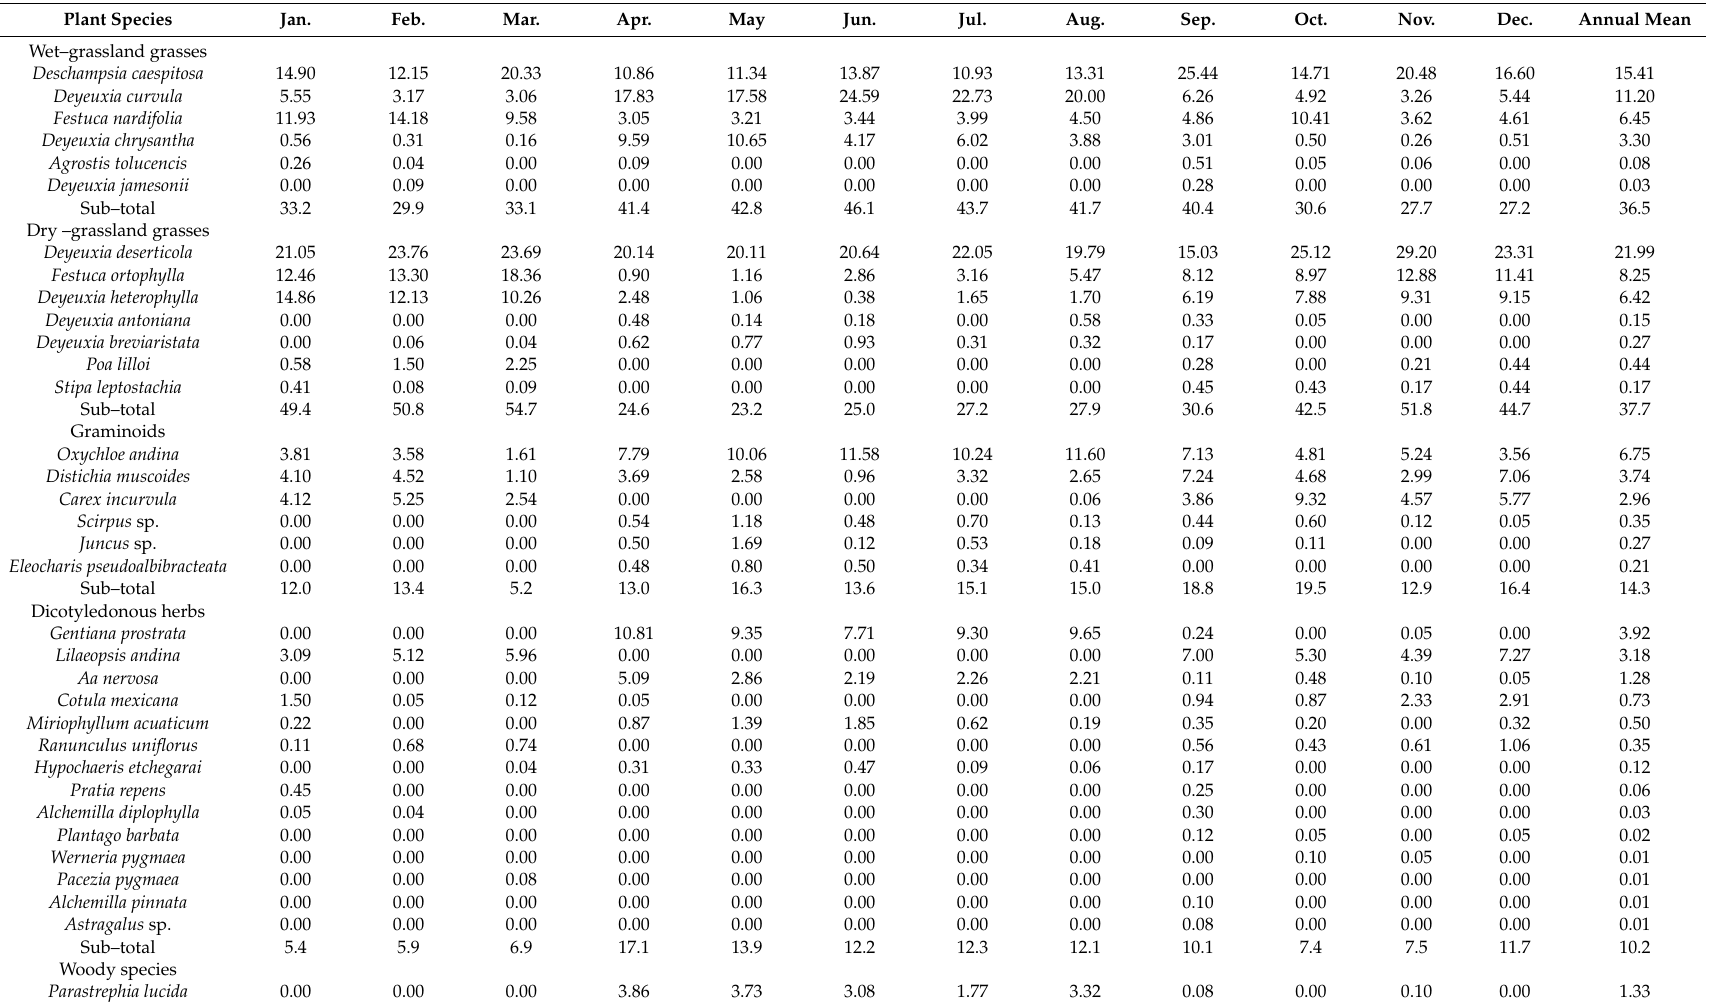
Table 2. Mean monthly contribution of di ff erent plant species to the diet of vicuñas that graze on natural grasslands of a sector of the Chilean highlands in Caquena, Putre County (18 ◦ 03 S, 69 ◦ 13’ W; 4425 m.o.s. l.), Arica and Parinacota Region, Chile. Plant Species Jan. Feb. Mar. Apr.